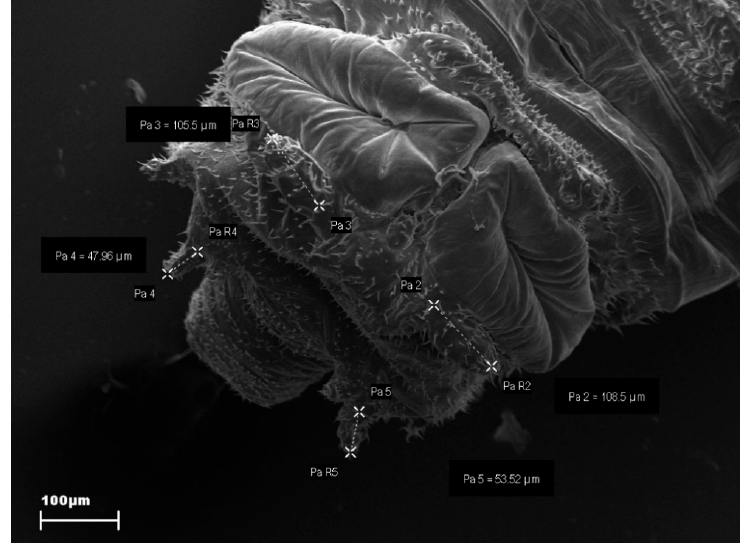
Figure 1. SEM picture of measured anal papillae. Drosophila melanogaster larvae exposed to 300 mg neomycin/L.